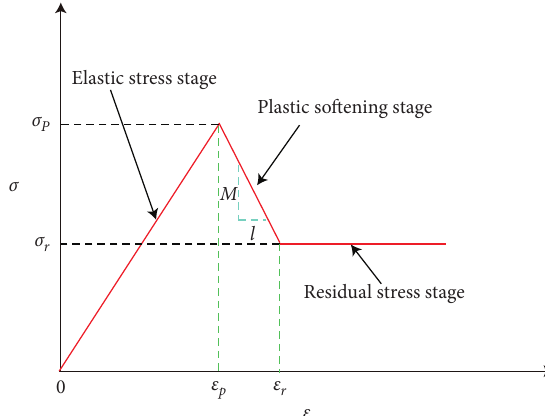
Figure 8: Simplified stress-strain curve for a conventional triaxial compression test. σ p denotes the peak strength. σ r denotes the residual strength. M denotes the softening modulus. ε p denotes the peak strain. ε r denotes the residual